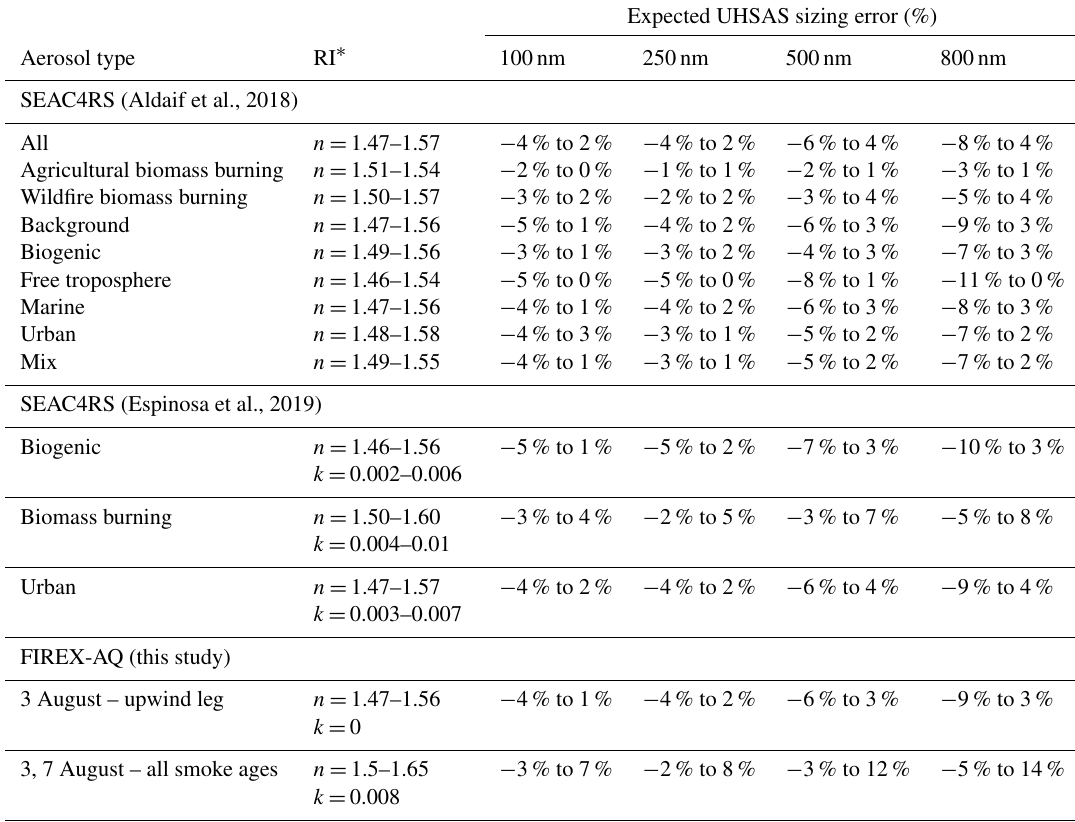
Table 3. Expected percent UHSAS sizing error associated with an atmospherically relevant range of refractive indices (RIs) computed for each size by linearly interpolating between the laboratory response curves of NaF, (NH 4 ) 2 SO 4 , NaCl, and SRFA, as shown in Figs. 5 and